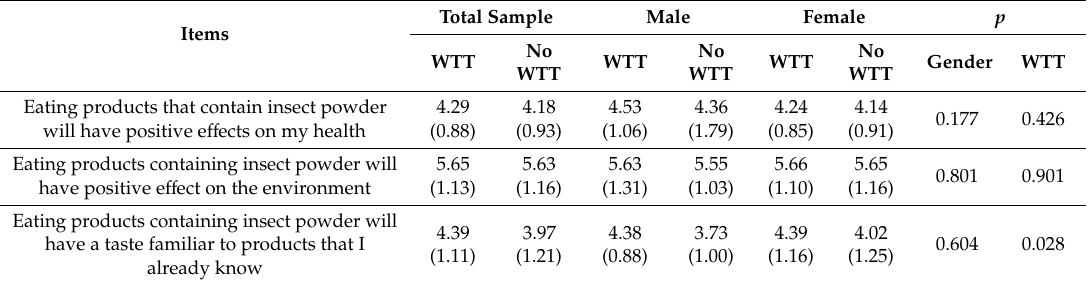
Table 1. Mean values (standard deviation) of the behavioral beliefs and the e ff ects and interactions with willingness to try (WTT) and